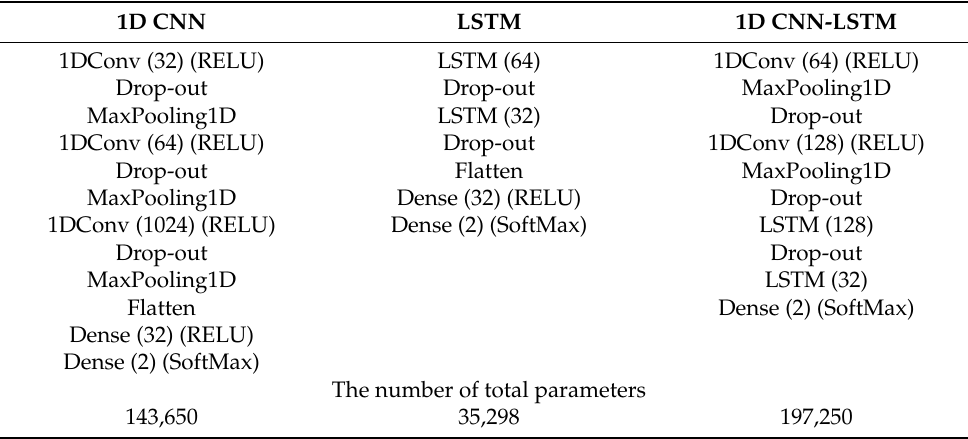
Table 5. The structural design for deep learning algorithms in the frequency